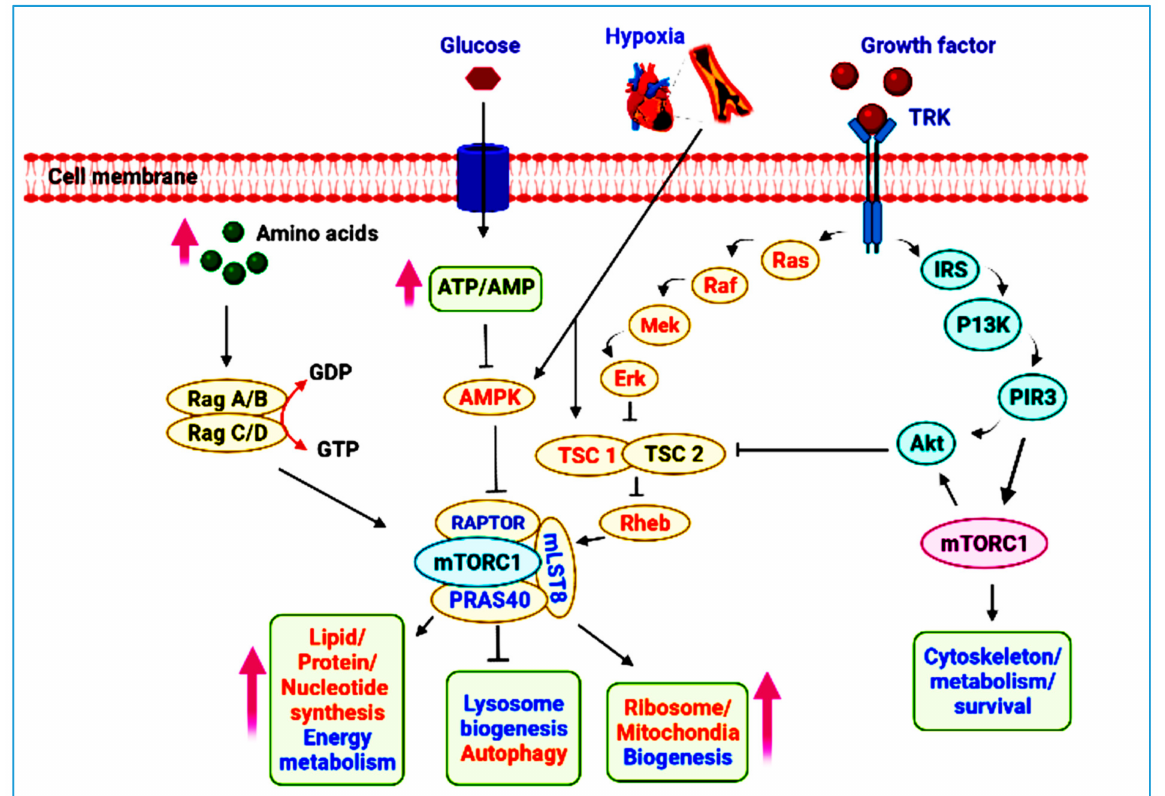
Figure 1. The structural components, types, and physiological role of mTOR signaling pathway. Upward and downward direction of arrows indicate the increase or decrease of process or